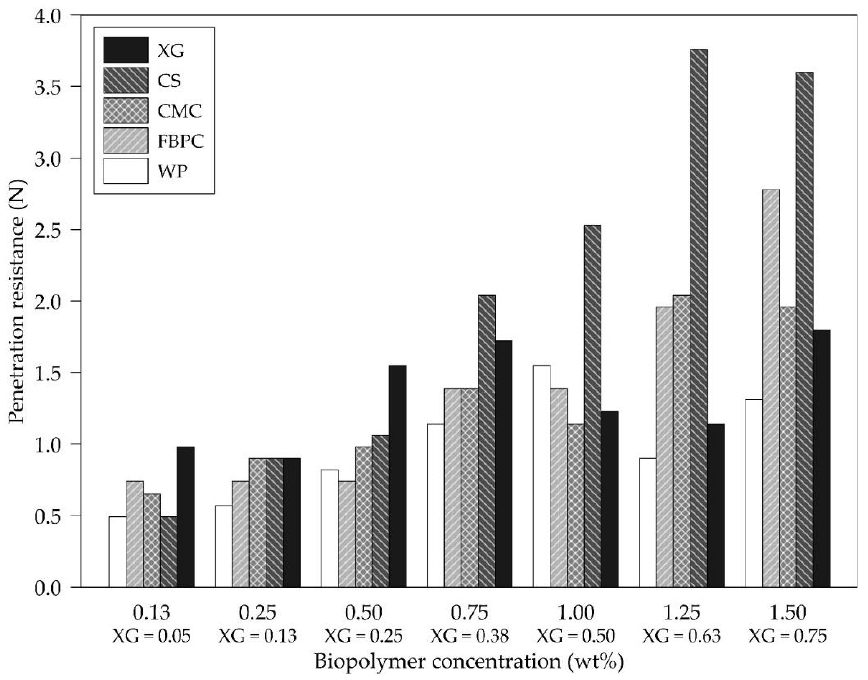
Figure 9. Penetration resistance of crusts after last wind tunnel test on day 28 of fine-grained silica sand. Penetration resistance tests were performed with six replicates (n = 6) with two penetrations per sample. Numerical data (mean (M) and standard deviation (SD)) are appended in Table A4.